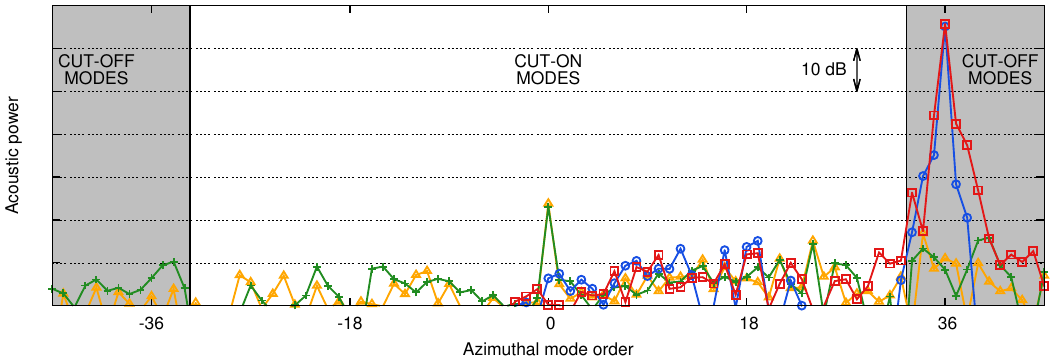
Figure 20. Acoustic power of the azimuthal modes composing the 2BPF radiated upstream: WSI noise in the axisymmetric case in orange line marked with triangles, WSI noise in the asymmetric case green line marked with crosses, DRI noise in the axisymmetric case in blue line marked with circle and DRI noise in the asymmetric case in red line marked with